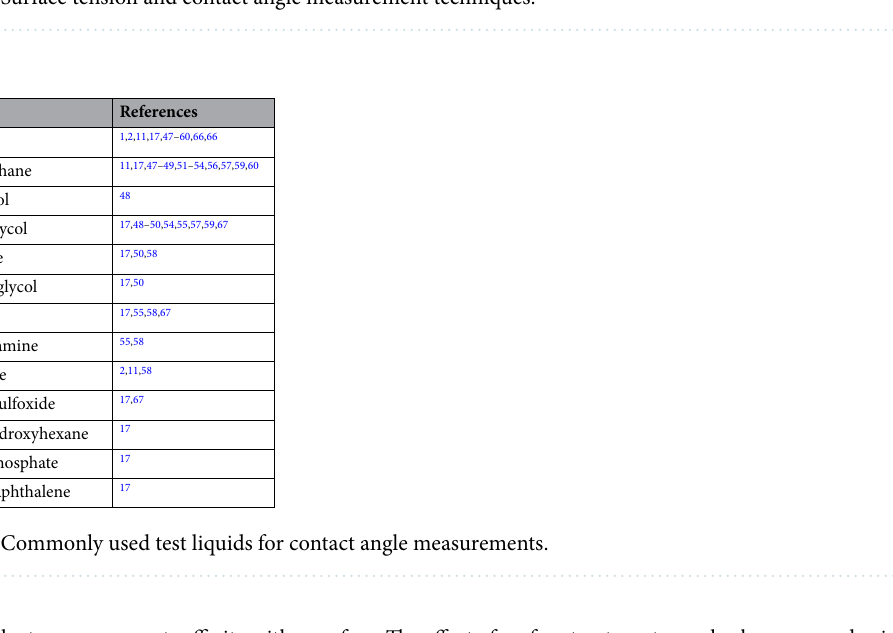
Table 1. Surface tension and contact angle measurement techniques.